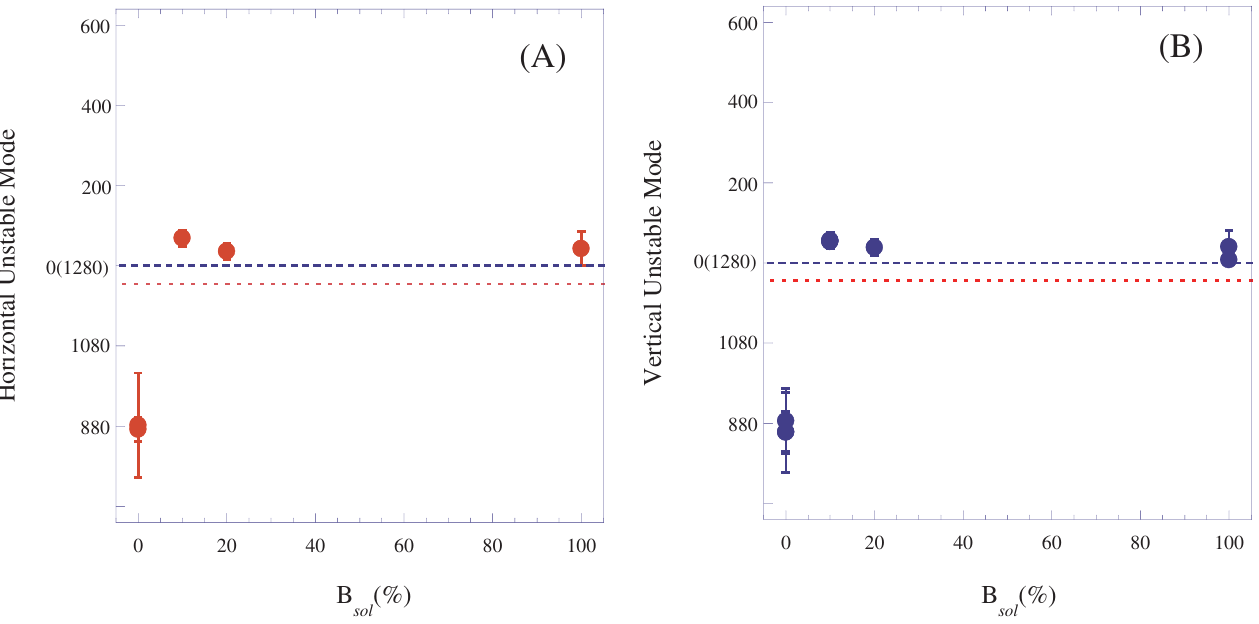
FIG. 16. (Color) Unstable modes [horizontal (a); vertical (b)] with a solenoid field. The error bars reflect the bottom-to-bottom width of the unstable modes. The red dotted line show the integer part of the betatron tune. The upper modes than those of the red line are caused by the focusing wake and the lower modes are caused by the defocusing